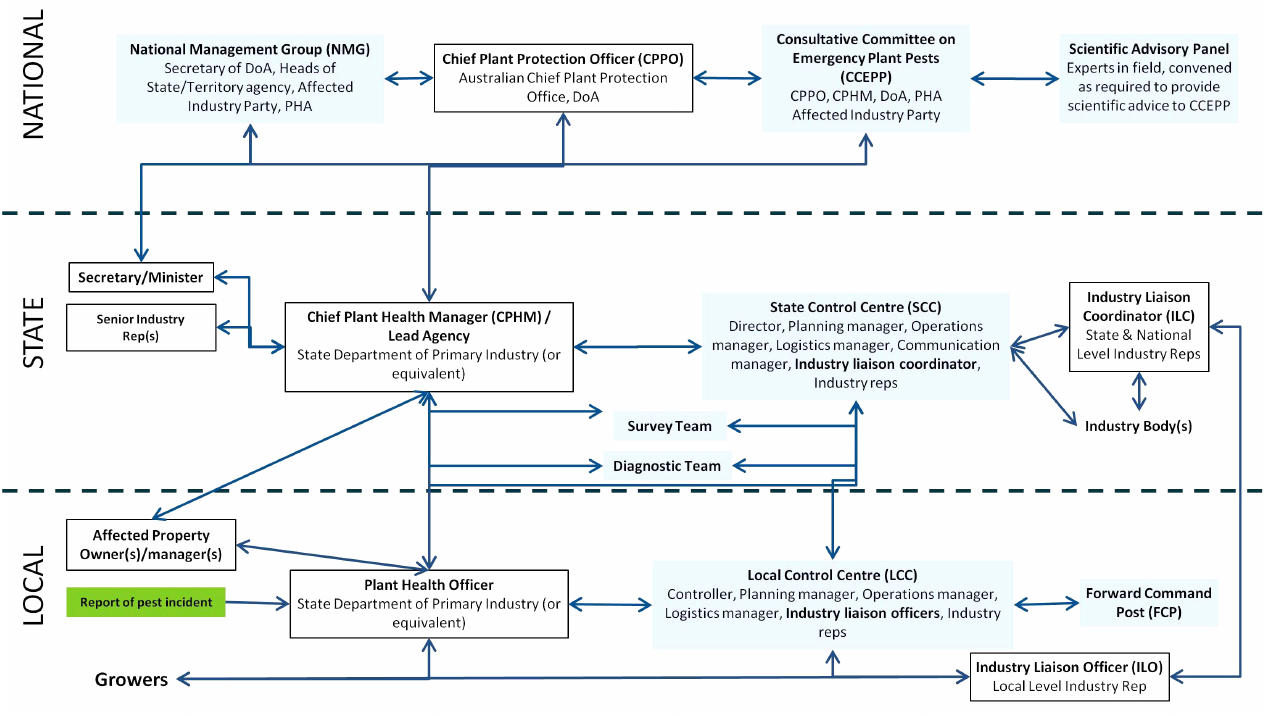
Fig. 1 . The Australian Emergency Plant Pest Response Deed: a simplified representation of the key players and the communication pathways in responding to a biosecurity incursion. Shaded boxes show various committees, management groups, or specialist teams that are formed when a risk is detected, with participating roles summarized. Unshaded boxes show defined roles that are central to information transfer within the network. Note that PHA refers to Plant Health Australia, and DoA to the Australian Department of Agriculture. See Plant Health Australia (2013) for more